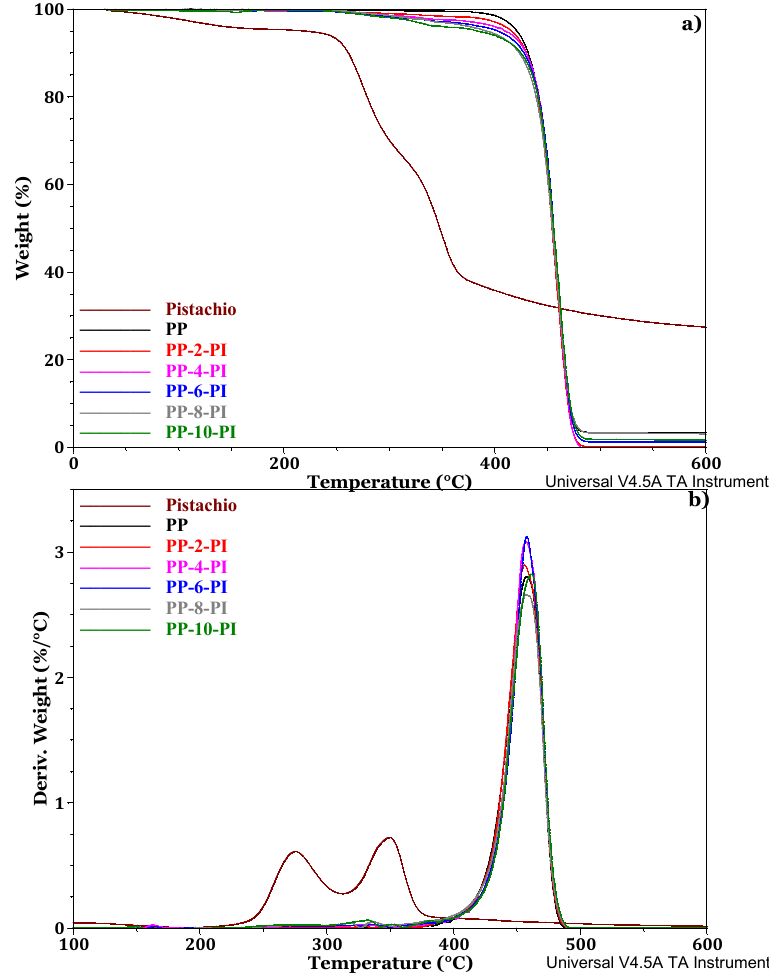
Figure 4. TGA thermogram of % weight loss ( a ) and derivative of %wt(°C), ( b ) for PP, PI, and PP-PI composites.